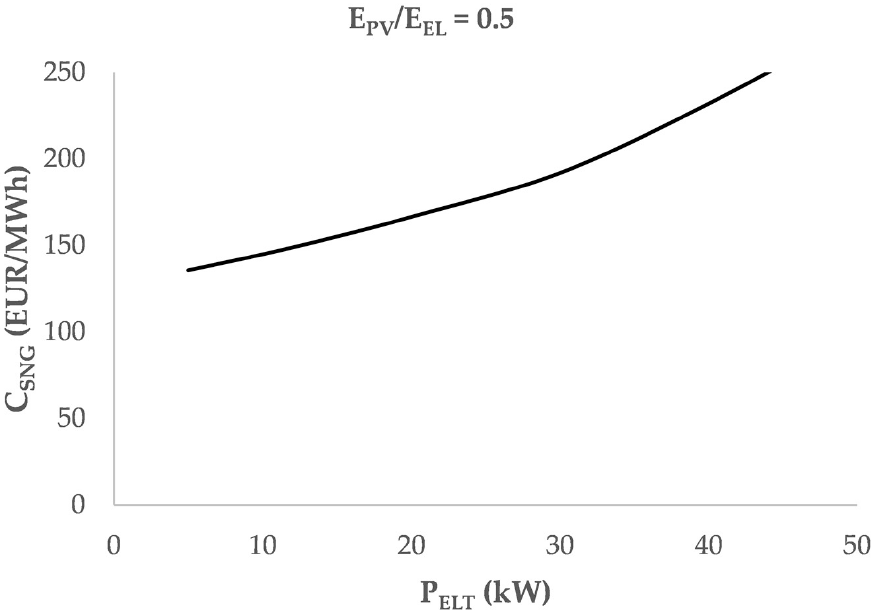
Figure 7. SNG production cost versus the rated power of electrolyser in the scenario E PV /E EL equal to 0.5.